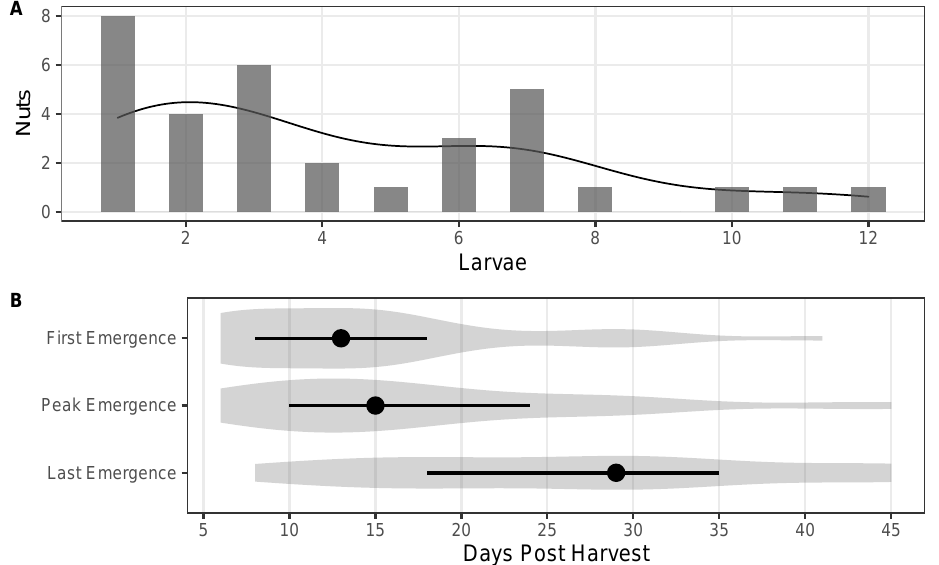
Figure 1. Larval C. sayi emergence from individual chestnuts. ( A ) Number of C. sayi larvae emerging from each individual chestnut. Each bar indicates the number of nuts having that many C. sayi larvae emerge. The line indicates the smoothed density distribution of that emergence. ( B ) Time to emergence by C. sayi larvae. First emergence denotes the amount of time to when the first C. sayi larva was observed leaving the nut. Peak emergence denotes the time to when the most number of larvae were observed leaving the nut on a given day. Last emergence denotes the time to when the last C. sayi larva was observed emerging from the chestnut. Shaded grey areas denote density distributions for each metric. Points denote the median. Error bars denote the first and third